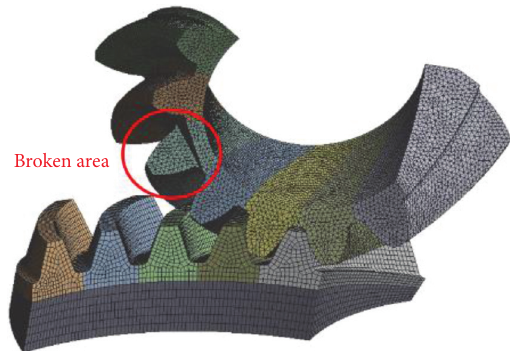
Figure 4: Meshing simulation model of spiral bevel gear.